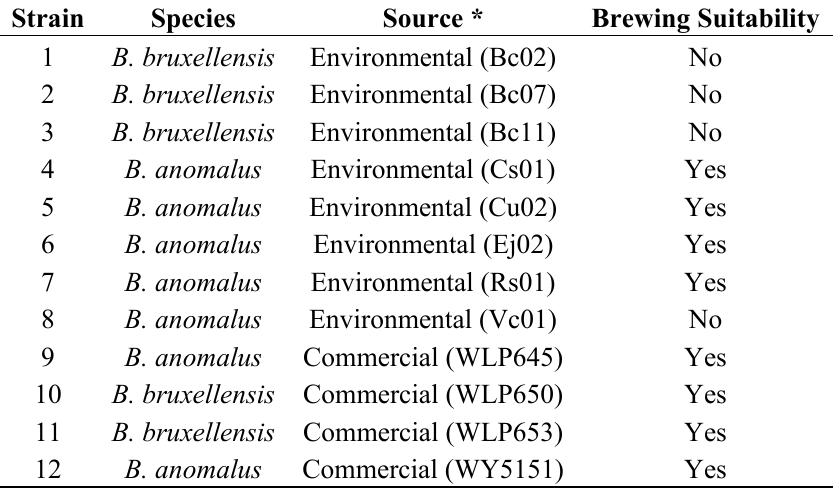
Table 1. Strain designation, source and suitability for